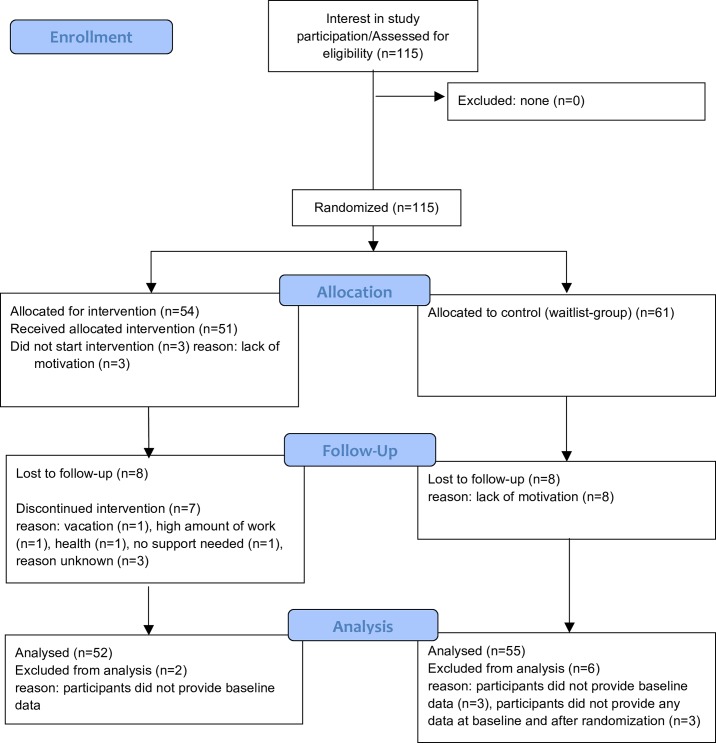
CONSORT 2010 flow diagram: Healthy ageing at work.